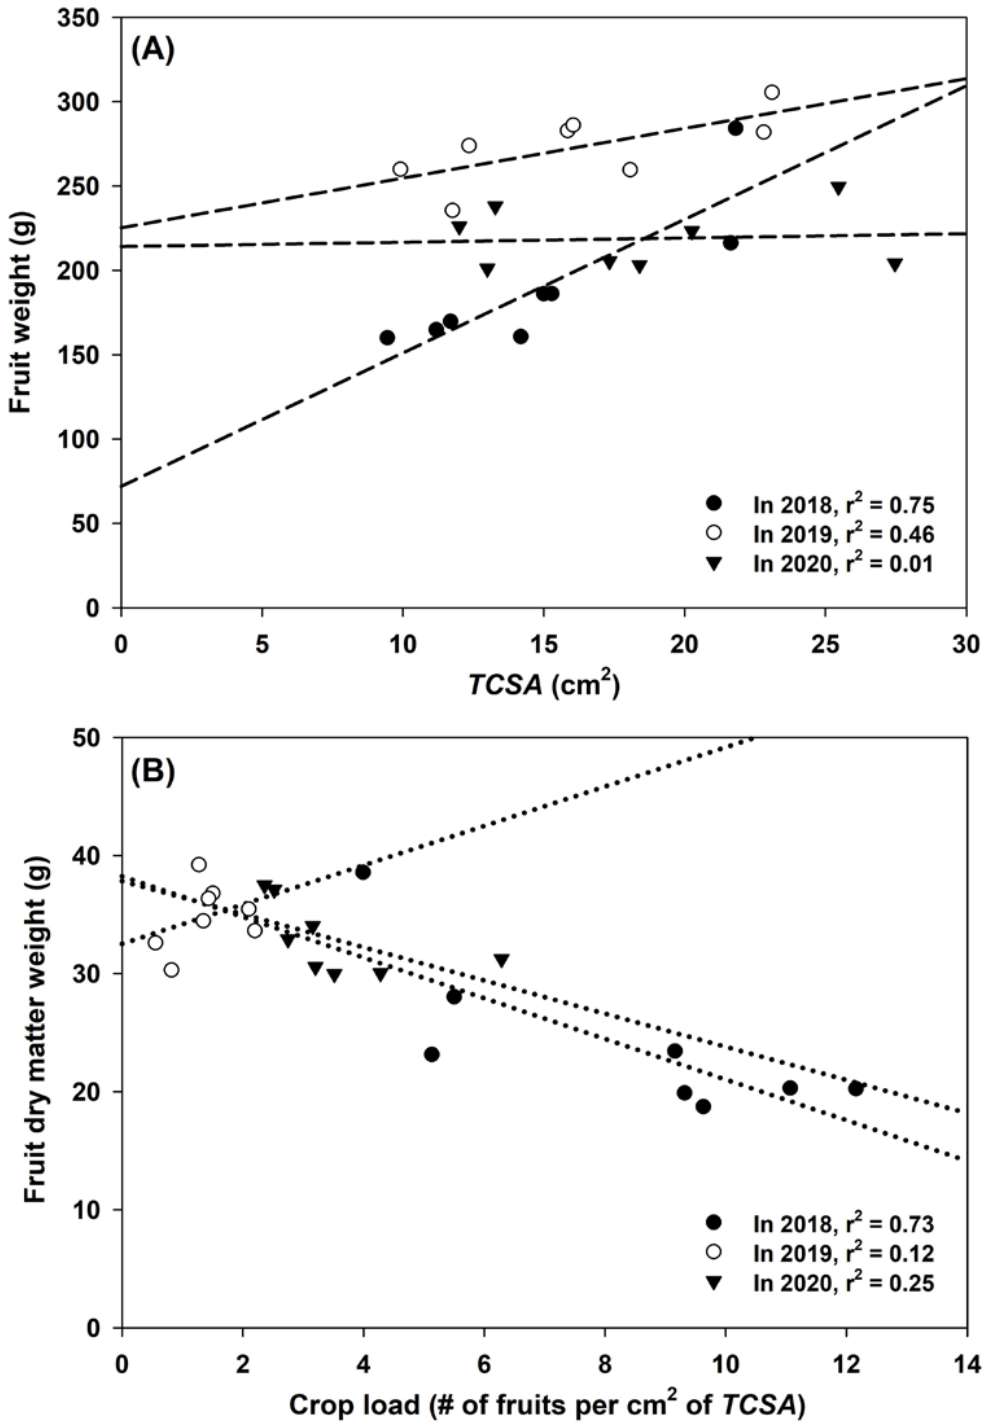
Figure 3. Correlations between trunk cross-section area and fruit weight ( A ), and between crop load and fruit dry matter weight ( B ), of Honeycrisp apples across rootstocks in 2018, 2019, and 2020. Each dot stands for the mean of three trees of a rootstock. Regression analysis was conducted to compute the coefficient of determination r 2 for the pair of parameters in every year (linear model).